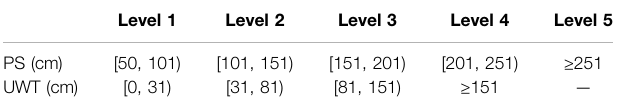
TABLE 4 | Level intervals of the daily peak surge (PS) and ultra-warning tidal level